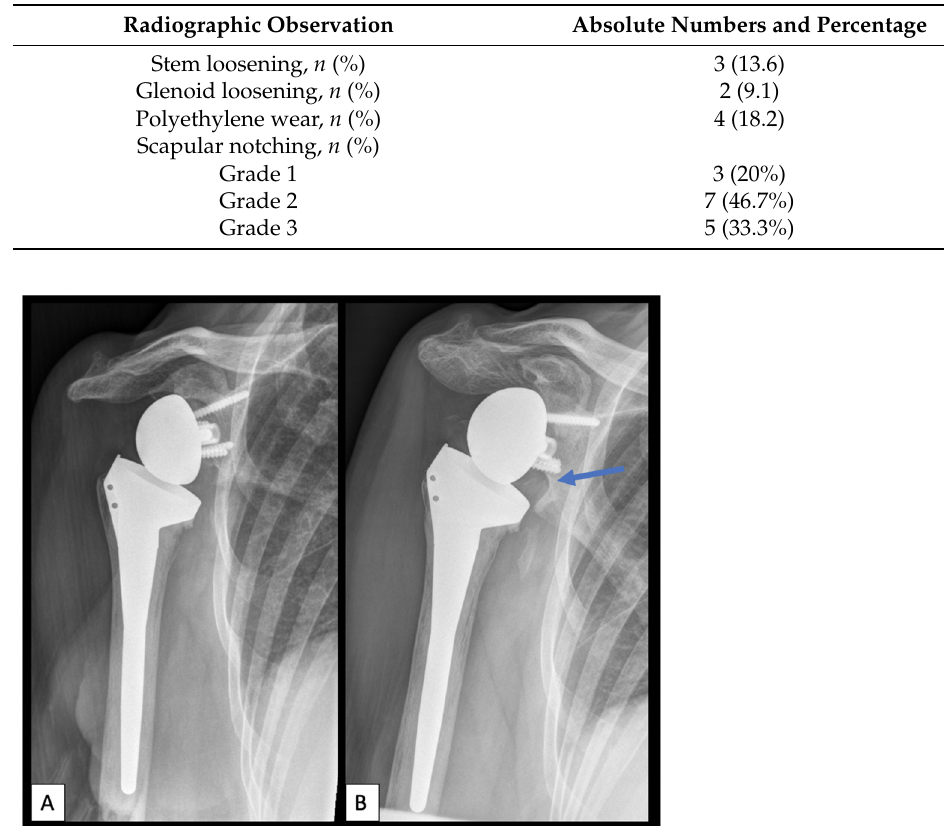
Table 4. Radiographic outcomes.